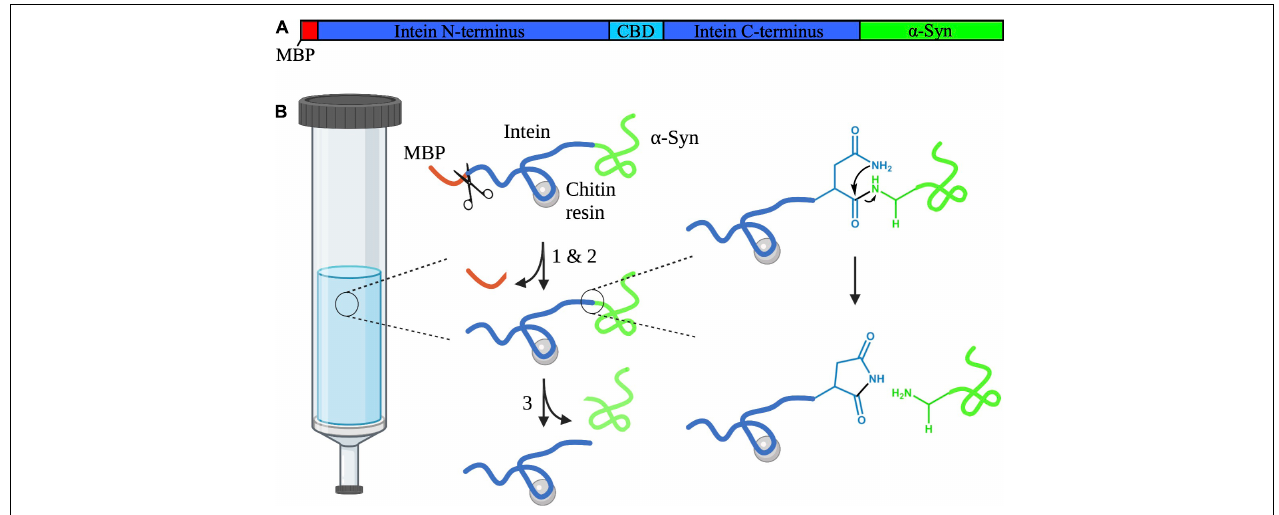
FIGURE 1 | (A) Schematic diagram depicting the domains of the intein-7–140 α -syn fusion protein. The MPB fragment is shown in red, the Sce VMA intein containing the CBD in blue, and α -syn in green. This figure was created using SnapGene Viewer 6.0 (from Insightful Science; available at snapgene.com). (B) Representation of the VMA intein fusion protein cleavage reaction. (1) N-S acyl rearrangement at the intein N-terminus. (2) BME-mediated N-terminal cleavage. The BME is represented here as scissors. (3) Spontaneous cyclisation at the intein C-terminus occurs, cleaving truncated α -syn from the protein. This figure was created using BioRender and ChemDraw 18.2 (from PerkinElmer Informatics).